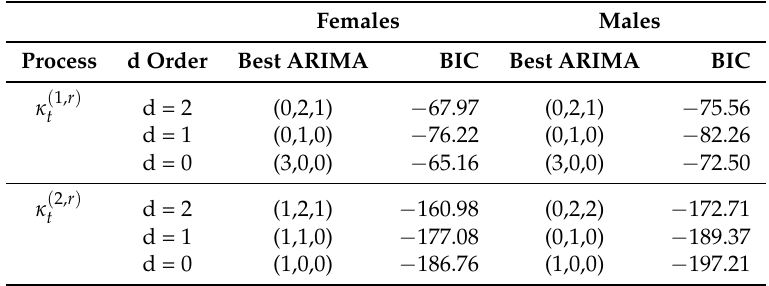
Table 10. BIC for different ARIMA processes for period effect in the Plat model for the reference population. Females